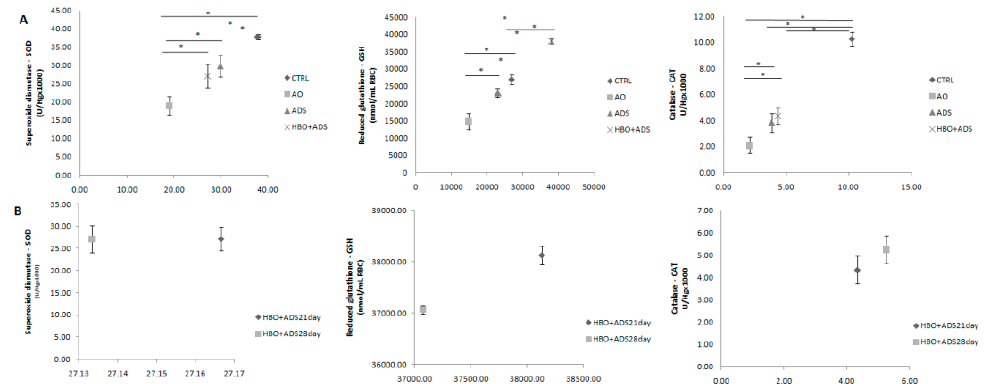
Figure 5. ( A ) Changes between CTRL, OA, ADS and HBO+ADS groups in the antioxidant enzyme activity in samples of erythrocyte lysate measured as superoxide dismutase (SOD), reduced glutathione (GSH) and catalase (CAT). ( B ) Changes between HBO+ADS 21days and HBO+ADS 28days groups in the antioxidant enzyme activity in samples of erythrocyte lysate measured as superoxide dismutase (SOD), reduced glutathione (GSH) and catalase (CAT). Values are presented as means ± mean standard error (SE). * p < 0.05 indicates statistically significant differences between groups.